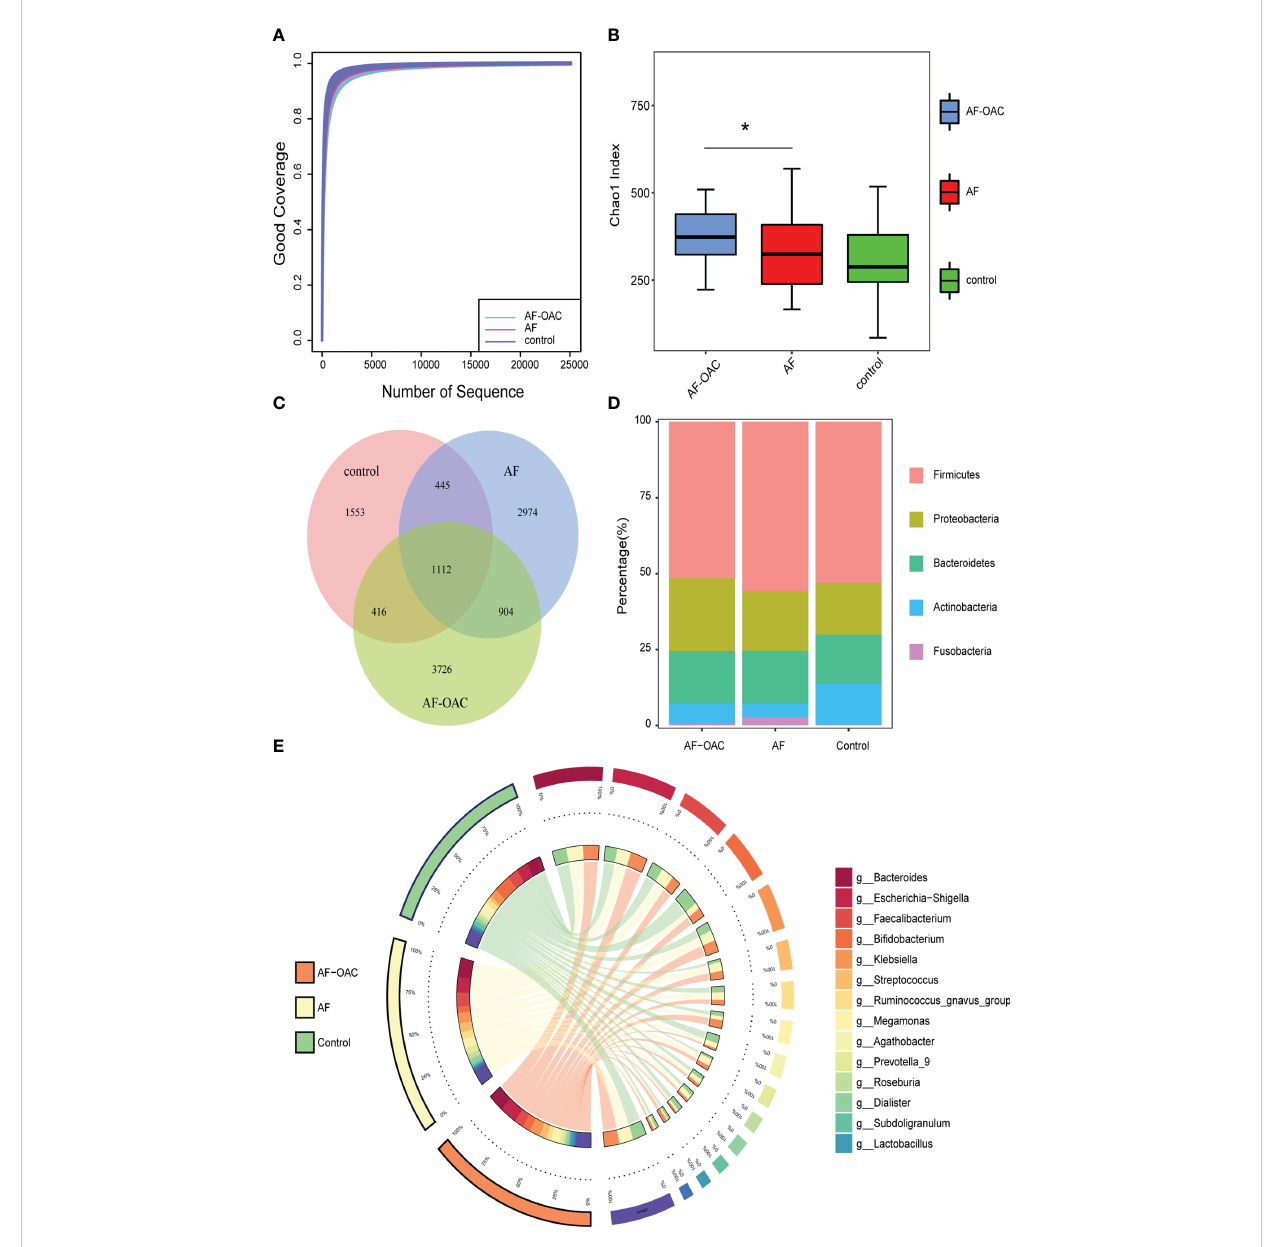
FIGURE 1 Overview of the gut microbiome in different groups. (A) Rarefaction analysis showed that the estimated ASV richness approached saturation in each group. (B) Alpha diversity, estimated by the Chao1 index, increased in the AF-OAC group, *P < 0.05. (C) Venn diagram showing the existence of ASVs in each group. (D) Dominant phyla in each group. (E) Dominant genera and their contribution to each